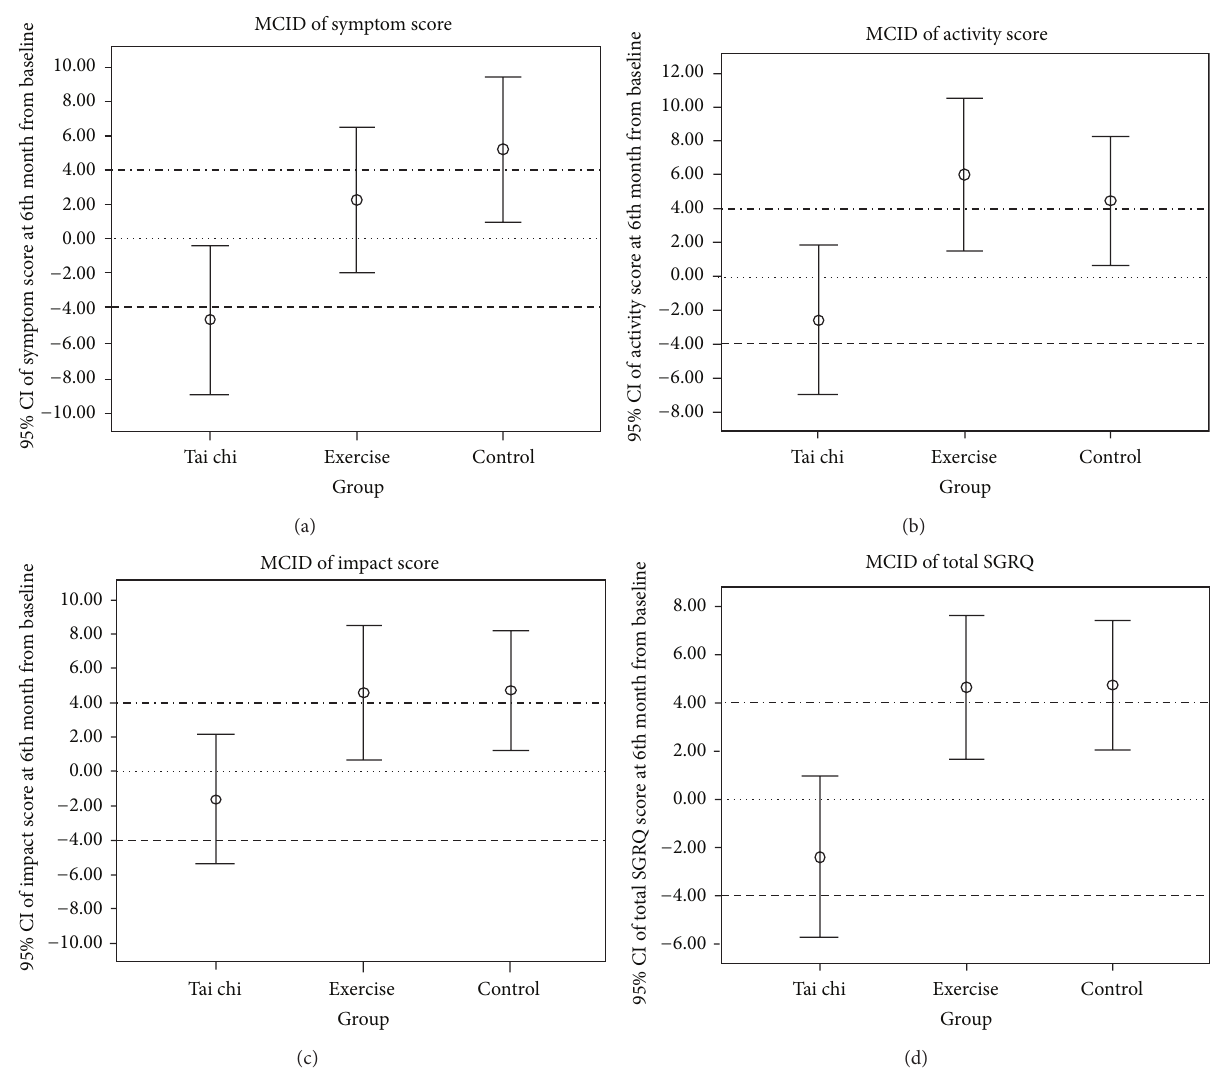
Figure3:Minimumclinicallyimportantdifference(MCID):changesintheSt.George’srespiratoryquestionnaire(SGRQ)scoresat6thmonth from baseline. ∘ Circles represent the mean; whiskers represent 95% confidence intervals; (dotted line) no change from baseline; (dashed line) ( − 4) threshold for positive clinical significance; (double-dotted line) (+4) threshold for negative clinical significance.